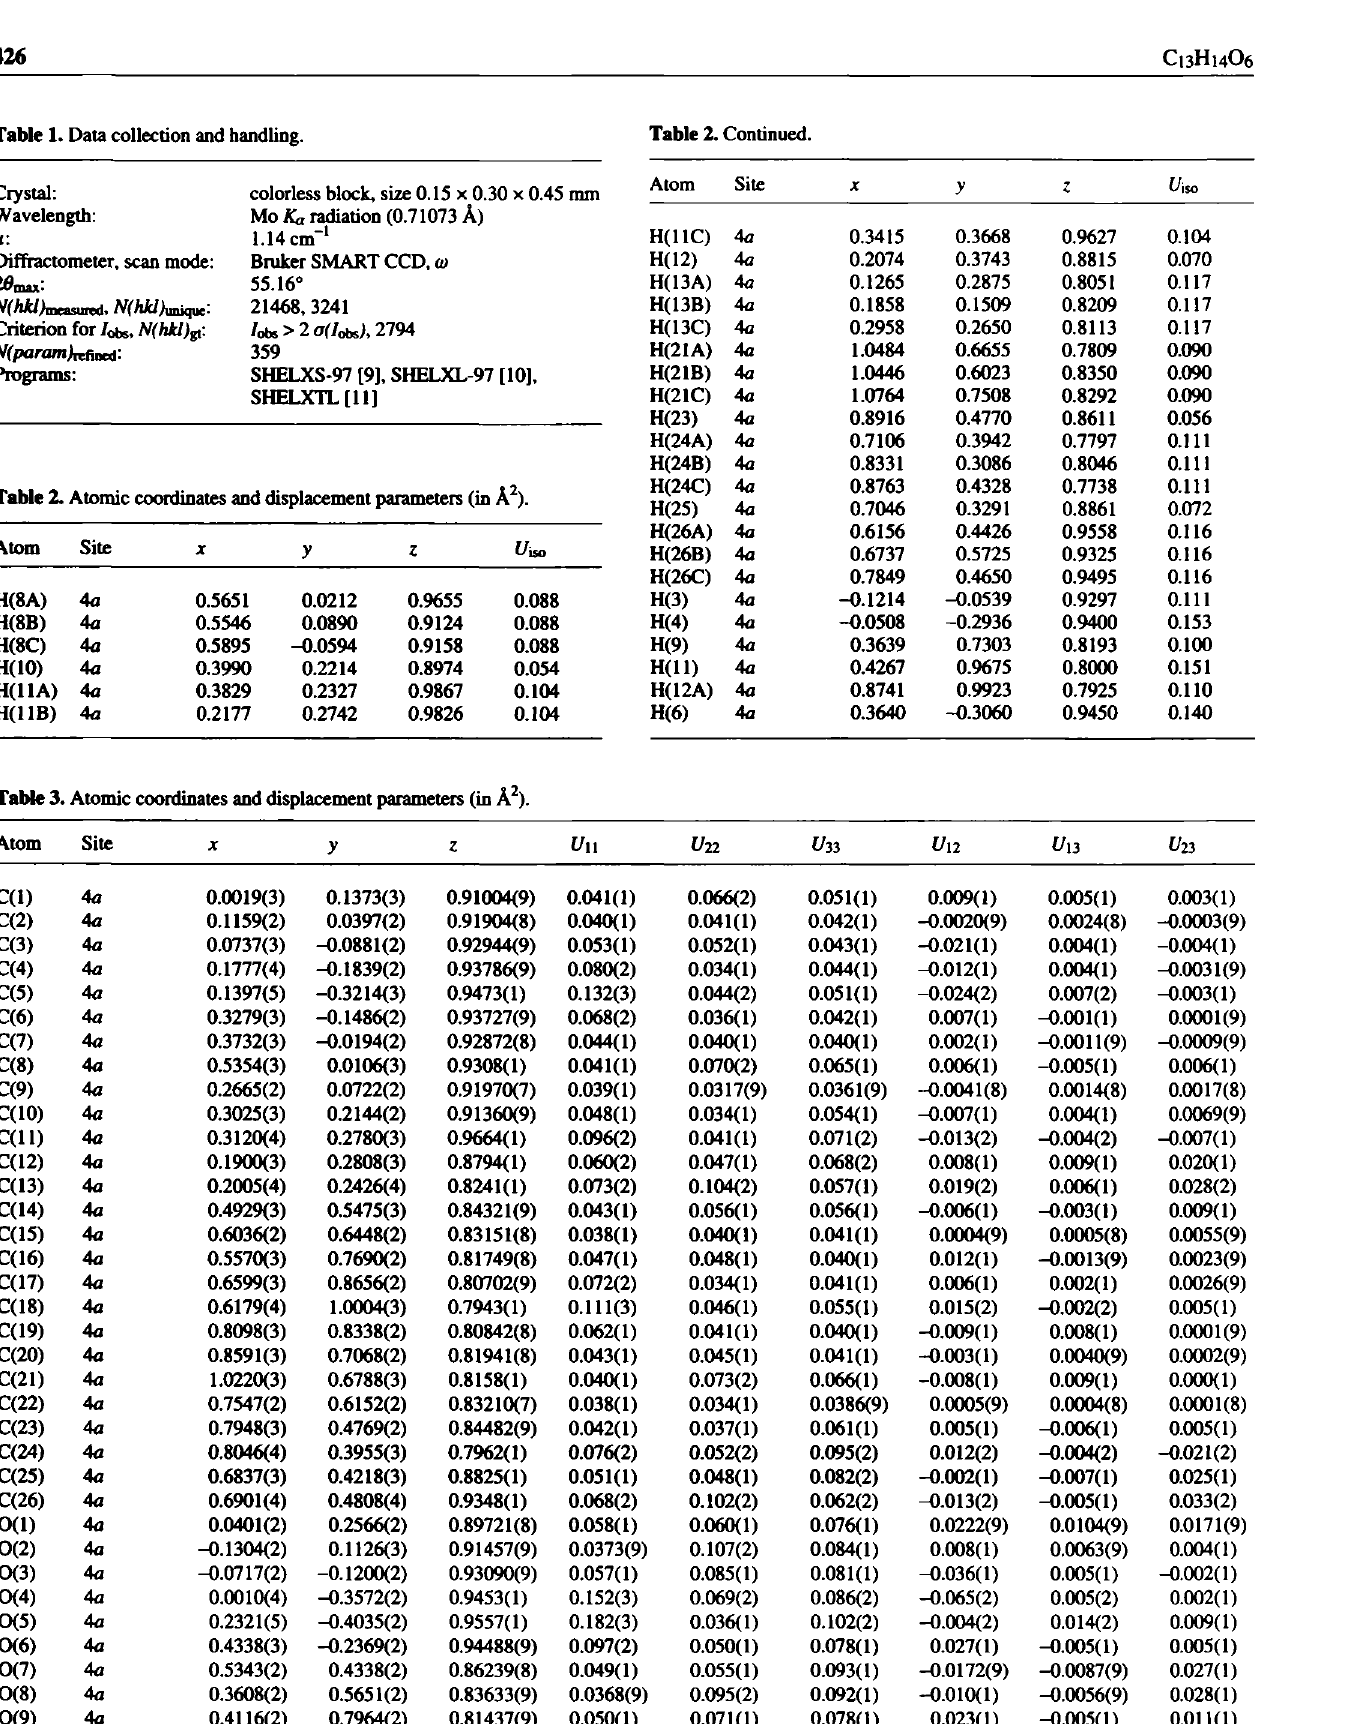
Table 1. Data collection and handling.